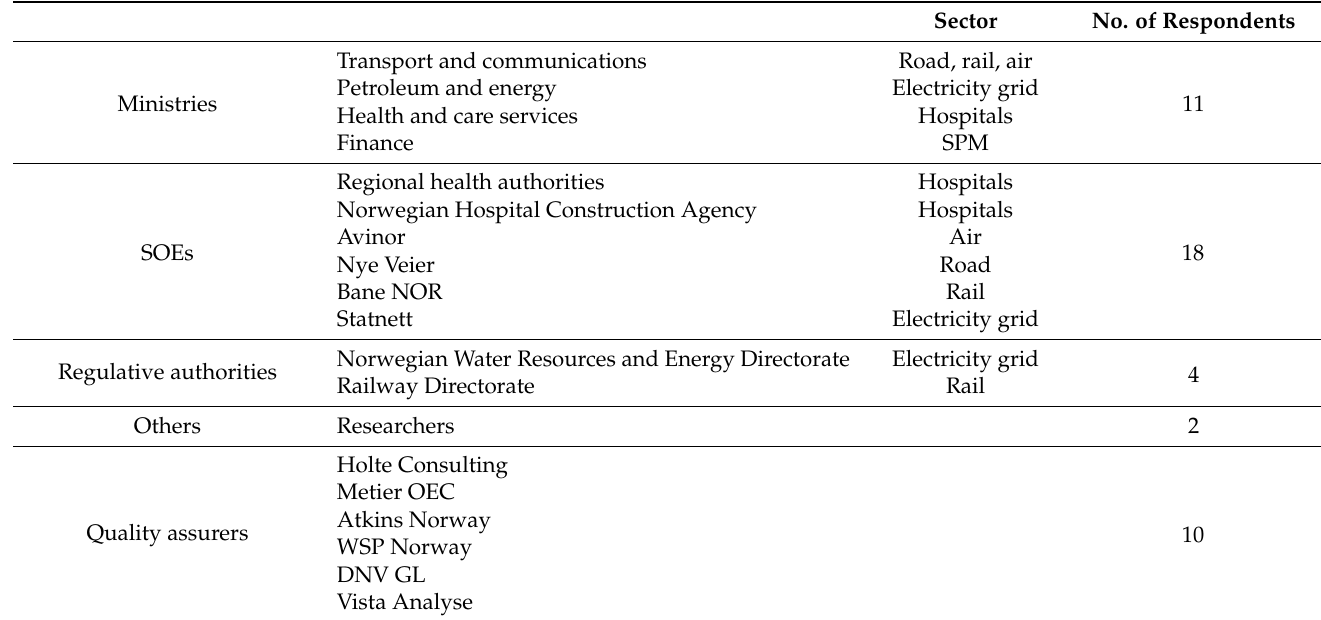
Table 1. Overview of the